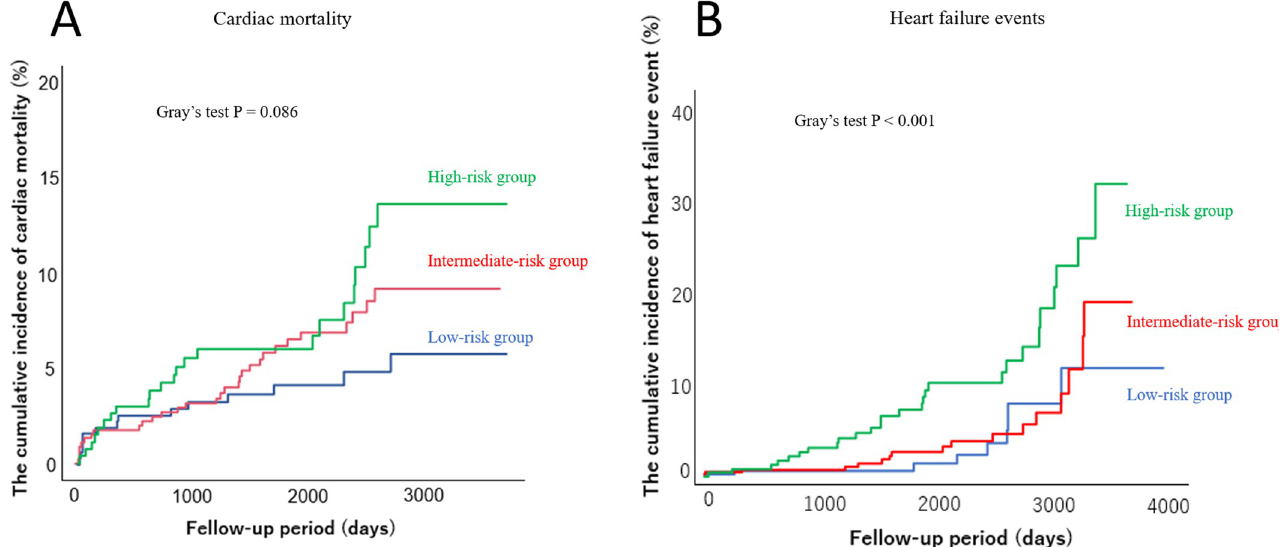
Fig 2. The cumulative incidence curves for cardiac mortality (A) and hospitalization due to heart failure (B) in the high, intermediate, and low PARIS thrombotic risk score groups. PARIS, the Patterns of non-Adherence to anti-platelet Regimen in Stented patient.